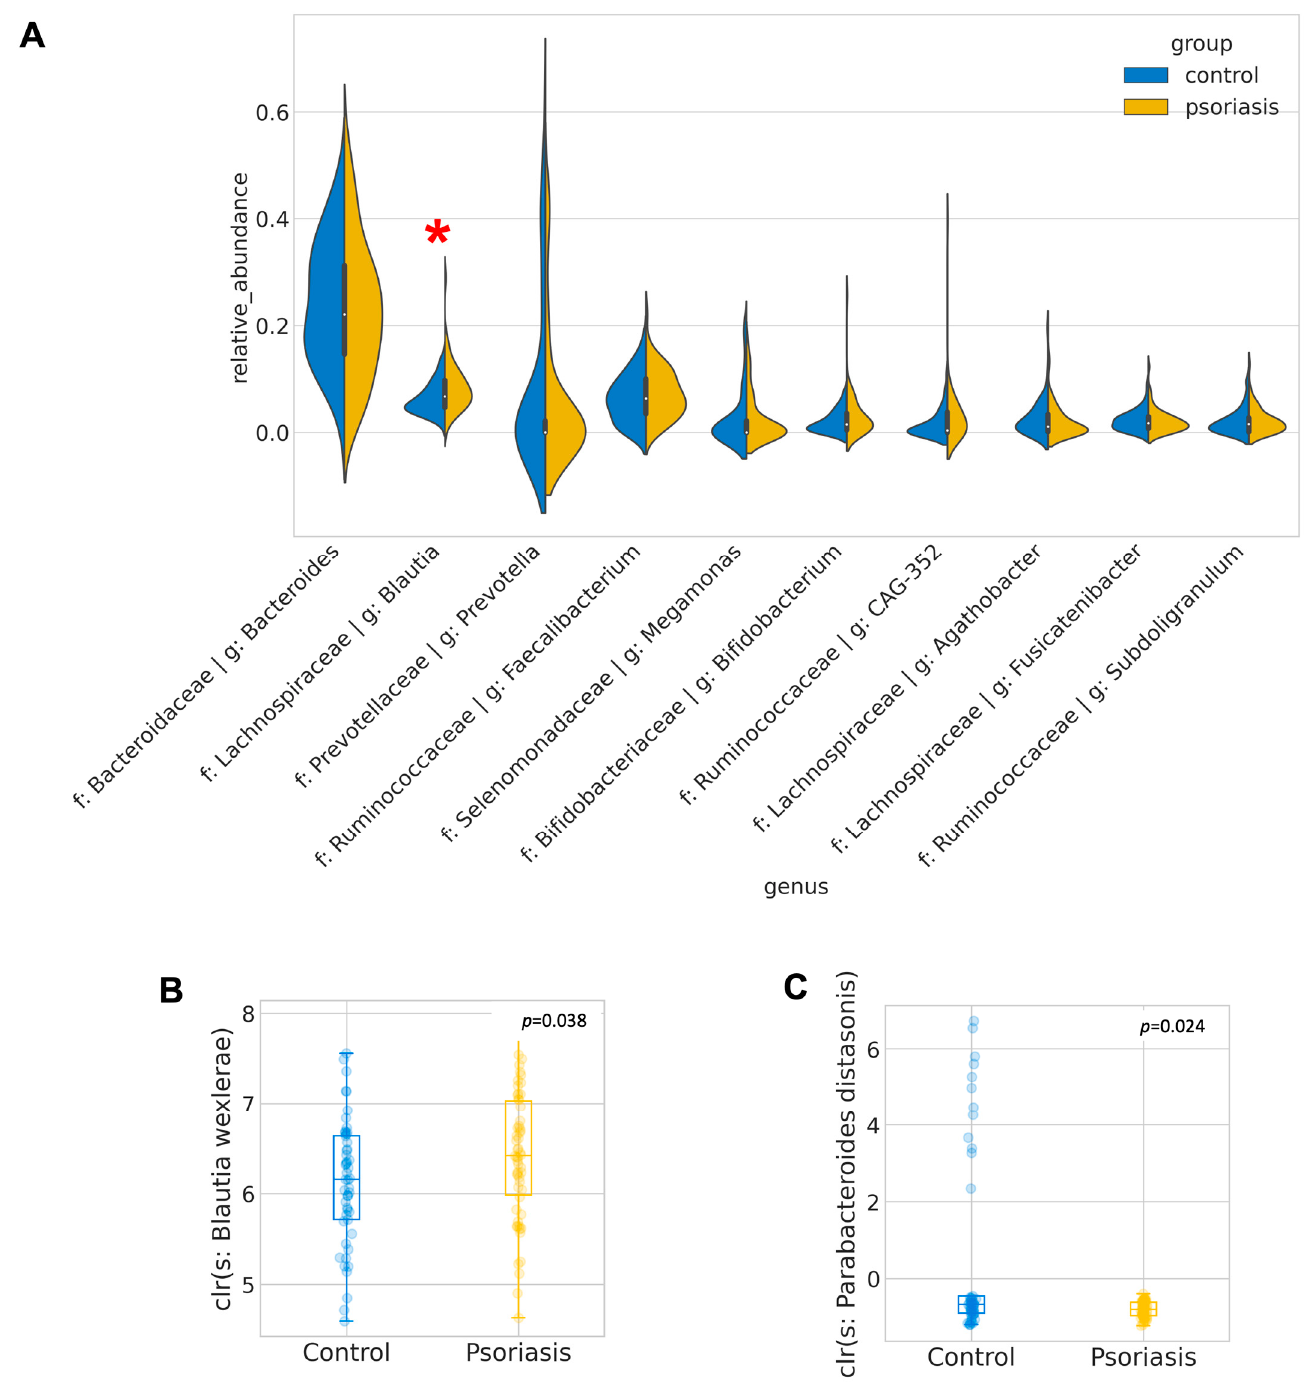
Figure 2. Most abundant and differentially abundant genera. ( A ) Distribution of relative abundance of the 10 most abundant genera. Differentially abundant genera are indicated by red asterisk. ( B , C ) Boxplot of center-log-ratio (clr) transformed abundance of Blautia wexlerae and Parabacteroides distasonis .